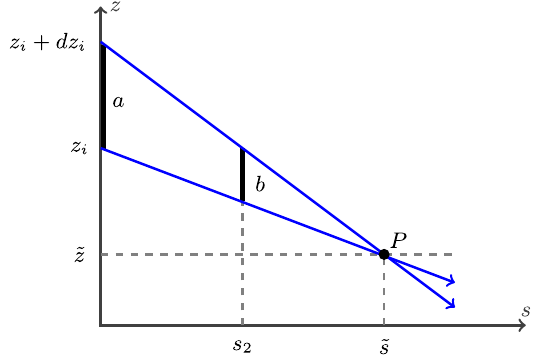
FIG. 9. Electron trajectories passing through a dispersive region. Labels a and b are used to mark the longitudinal distance separating the trajectories at s ¼ 0 and s ¼ s 2